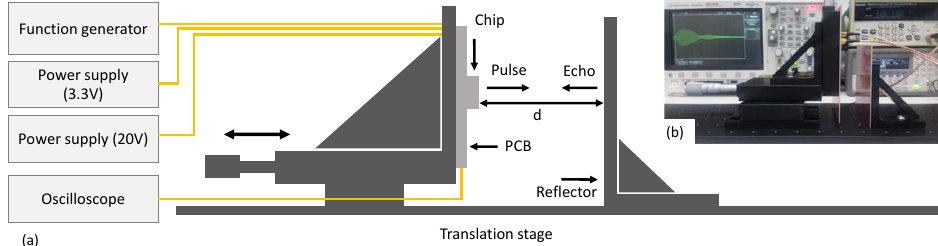
Figure 11. ( a ) Schematic and ( b ) photograph of the measurement setup.